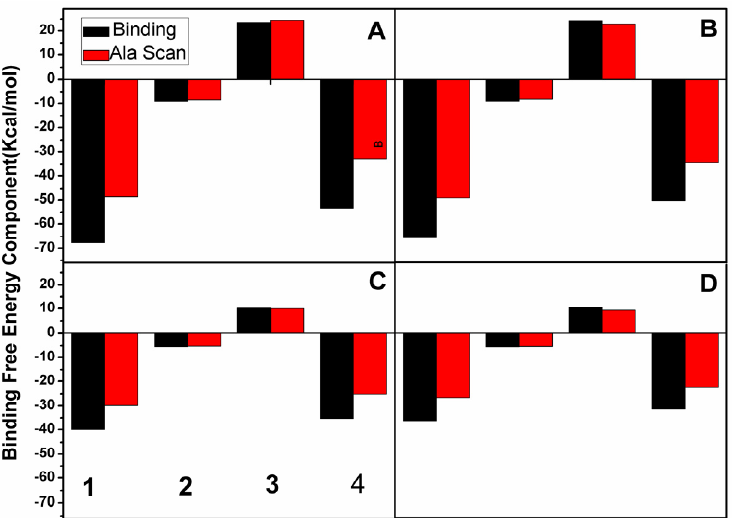
Figure 8. Changes of binding free energy components caused by alanine scanning. Binding of inhibitors to wild-type protein and mutated protein are represented by black and red,